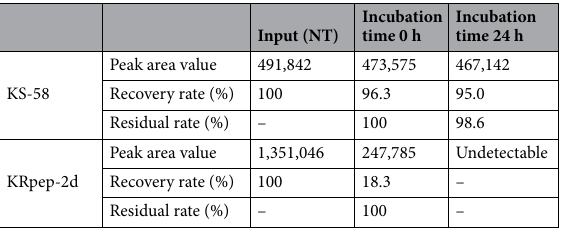
Table 4. Stability of peptide in rat plasma. NT means no-serum